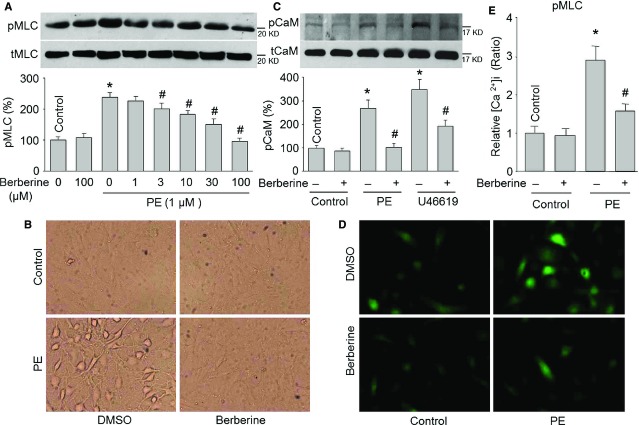
Berberine reduces intracellular Ca2+ concentration and induces direct relaxation in cultured human vascular smooth muscle cells (VSMCs). (A) Cultured human VCMCs were incubated with berberine as indicated concentration (1–100 μM) for 60 min. and then stimulated with PE (1 μM) for 30 min. Total cell lysates were subjected to perform Western blot for detection of pMLC levels. The MW of pMLC (or tMLC) is about 20 kD, which matches the expected sizes. The blot is a representative blot obtained from three independent experiments. Quantitative results are expressed as mean ± SEM, *P < 0.05 versus Control, #P < 0.05 versus PE alone. (B) Cultured human VCMCs were incubated with berberine (10 μM) for 60 min. and then stimulated with PE (1 μM) for 30 min. The representative picture of cell morphology was taken by the microscope from three independent experiments. (C) Cultured human VCMCs were incubated with berberine (10 μM) for 30 min. and then stimulated with PE (1 μM) or U46619 (30 nM) for 30 min. Total cell lysates were subjected to perform Western blot for detection of pCaM levels. The MW of pCaM (or tCaM) is about 17 kD, which matches the expected sizes. The blot is a representative blot obtained from three independent experiments. Quantitative results are expressed as mean ± SEM, *P < 0.05 versus Control, #P < 0.05 versus PE or U46619 alone. (D) Cultured human VCMCs were incubated with berberine (10 μM) for 60 min. and then stimulated with PE (1 μM) for 30 min. Intracellular Ca2+ ([Ca2+]i) concentration was assayed by detecting Fluo-4-AM fluorescence. Relative [Ca2+]i concentration was calculated by the ratio of fluorescent intensity to control. The fluorescent intensity in control was set up as 1. The representative picture was presented from three independent experiments. (E) Summary data for [Ca2+]i concentration in D. Quantitative results are expressed as mean ± SEM, *P < 0.05 versus Control, #P < 0.05 versus PE alone.